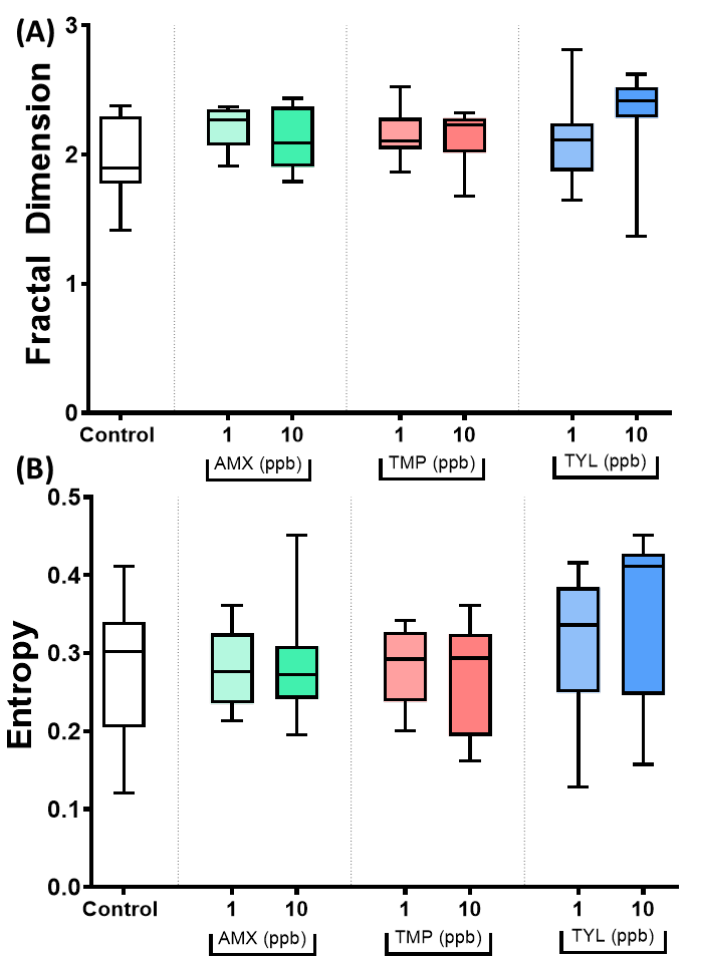
Figure A3. The comparison of ( A ) fractal dimension and ( B ) entropy value of control and antibiotic- treated zebrafish after 10 days exposure. The data were analyzed by ordinary one-way ANOVA followed by Dunnett’s test and compared to control group ( n control: 12, n for antibiotic groups: 12, except n for AMX 1 ppb and TMP 10 ppb: 11, and n TYL 10 ppb: 10). Abbreviation: AMX, Amoxicillin; TMP, Trimethoprim; TYL, Tylosin. Table A1. Characteristics of different antibiotics used in this study.